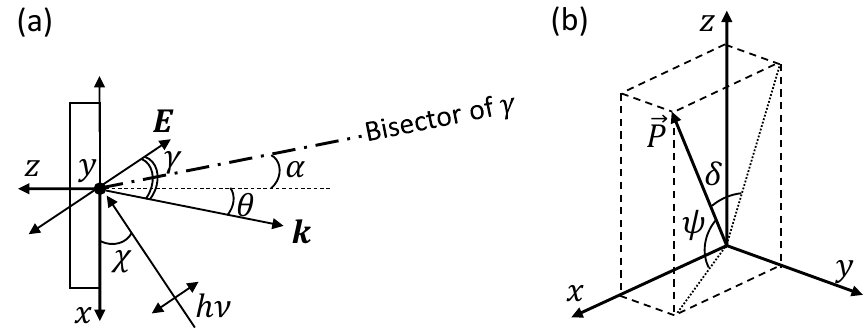
Figure 2: Definition of the relevant symmetry angles: (a) γ , θ , α , χ and (b) ψ , δ . See the text for